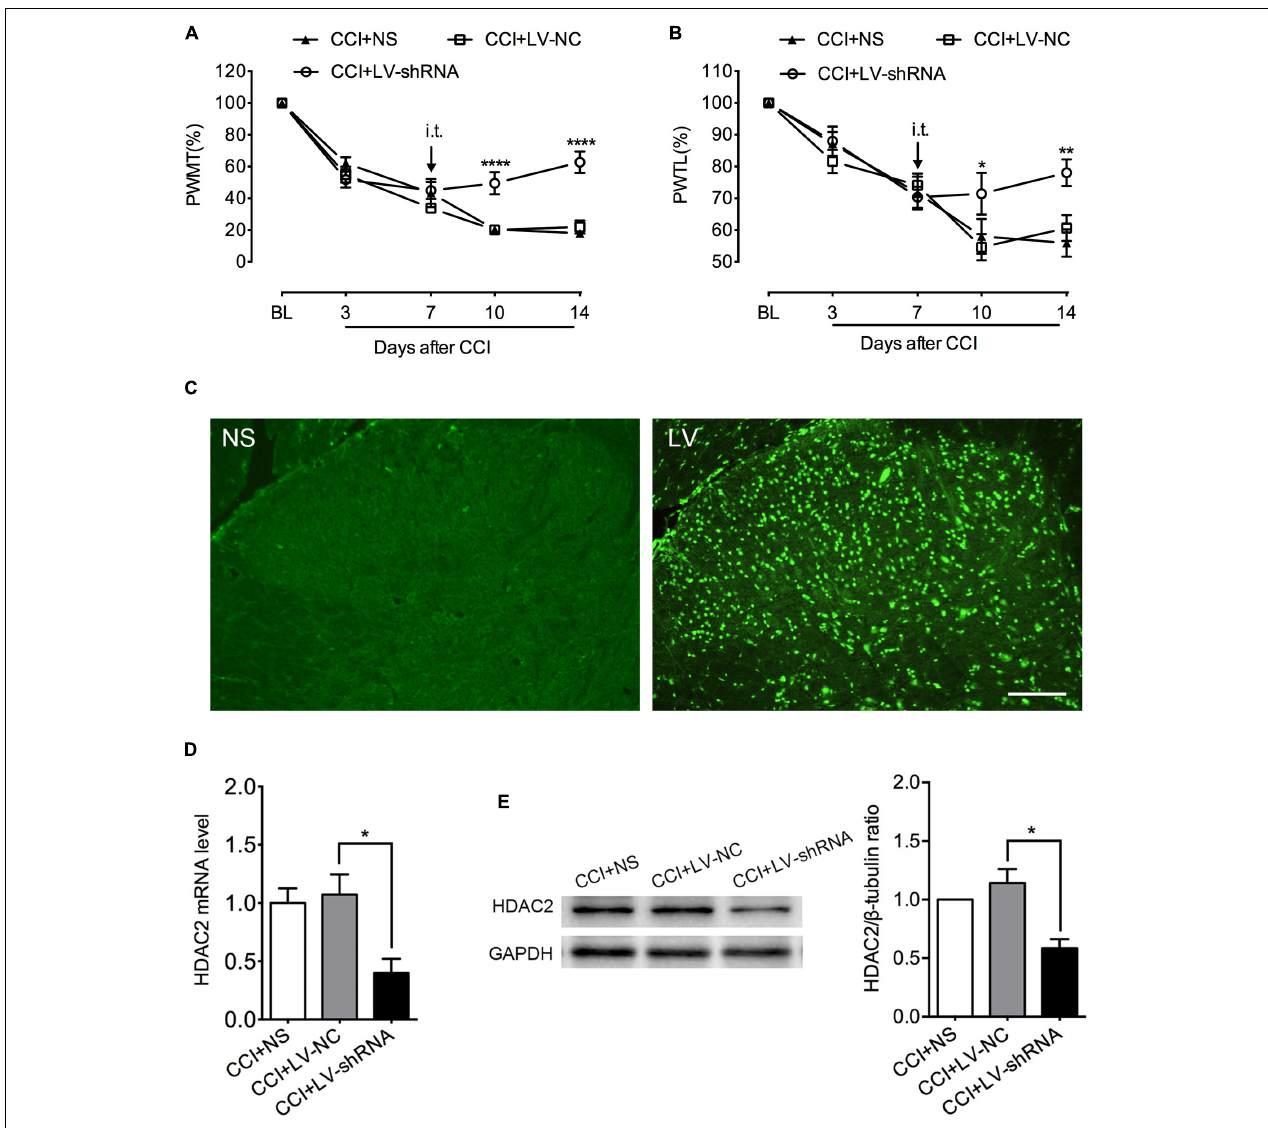
FIGURE 5 | Intrathecal administration of LV-shRNA-HDAC2 repressed HDAC2 mRNA and protein expression and alleviated mechanical and thermal hyperalgesia in CCI rats. (A,B) Intrathecal administration of LV-shRNA-HDAC2 partially reversed the mechanical and thermal hyperalgesia in CCI rats since day 10 post-injury, and the analgesic effect lasted to the end of behavioral tests ( n = 6 per group). ∗ p < 0.05, ∗∗ P < 0.01, ∗∗∗∗ P < 0.0001, CCI+LV-shRNA vs. CCI+LV-NC; BL, baseline; PWMT, paw withdrawal mechanical threshold; PWTL, paw withdrawal thermal latency. (C) Successful transfection with lentivirus was demonstrated by GFP signal (green) detected by immunofluorescent imaging of the lumbar spinal cord. NS: rats receiving normal saline; LV: rats with lentivirus injection, scale bar = 100 µ m. (D,E) Intrathecal injection of LV-shRNA-HDAC2 decreased HDAC2 mRNA and protein abundance in the lumbar spinal cord of CCI rats; n = 4 per group, ∗ p < 0.05.